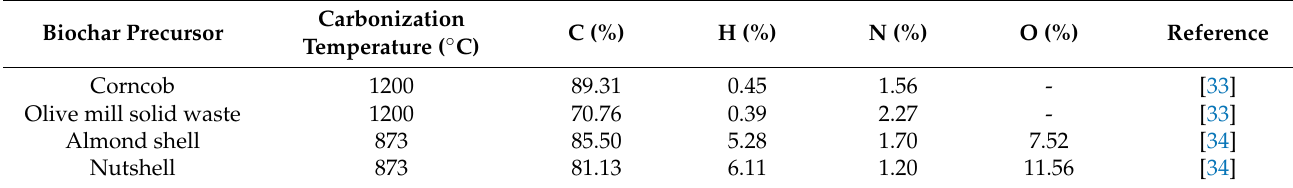
Table 2. Ultimate analysis reports of some